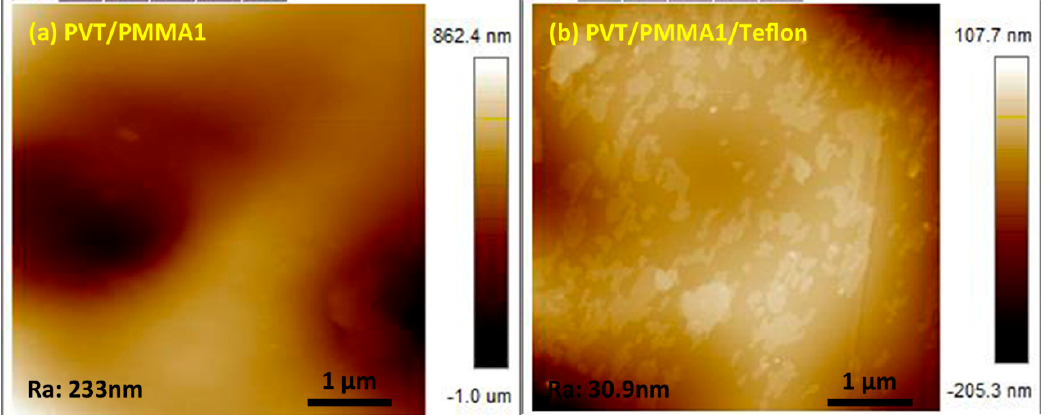
Figure 3. AFM image of ( a ) PVT/PMMA1 and ( b ) PVT/PMMA1/Teflon blended films.